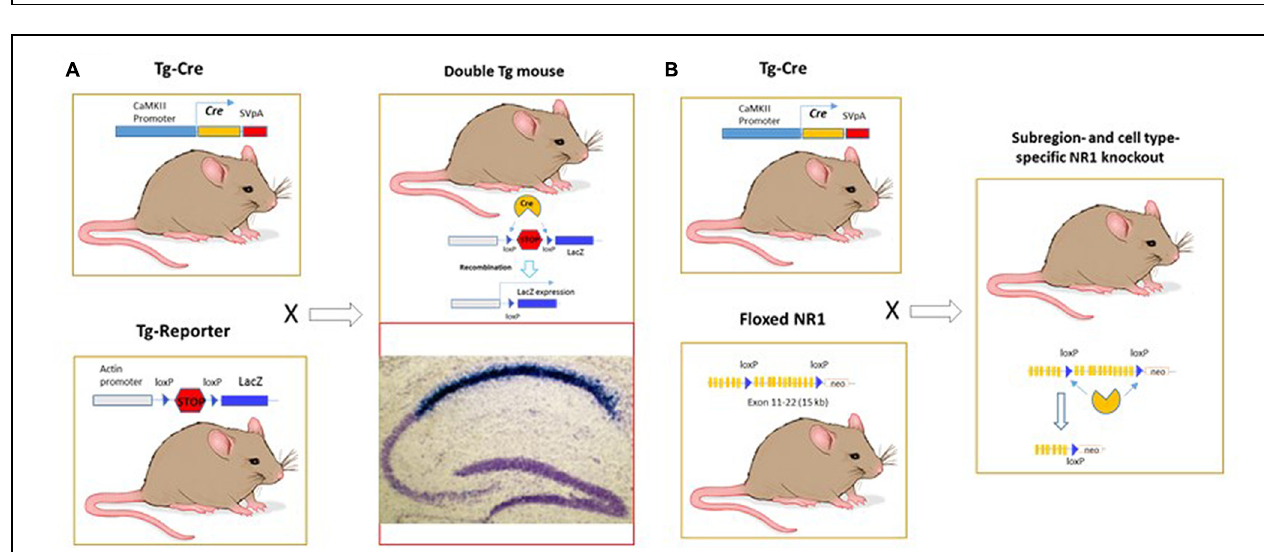
FIGURE 1 | DNA recombination involves complex topological and biochemical during DNA replication. DNA recombination is linked with DNA replication during cell divisions in order to exchange genetic materials for the selection of favorable mutations or the elimination of unfavorable or deleterious mutations. Recombination also comes with DNA injury and is therefore tightly coupled with the DNA repair mechanism. Nearly all neurons in the adult brain are post-mitotic to ensure their stability. This explains why brain tumors are in glial cells but not in neurons.